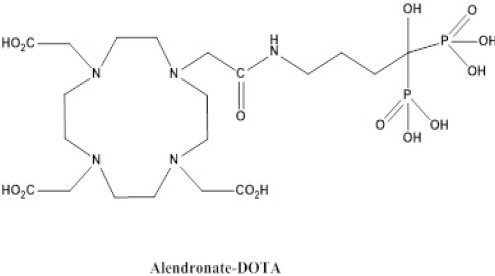
Chemical structure of DOTA-ALN